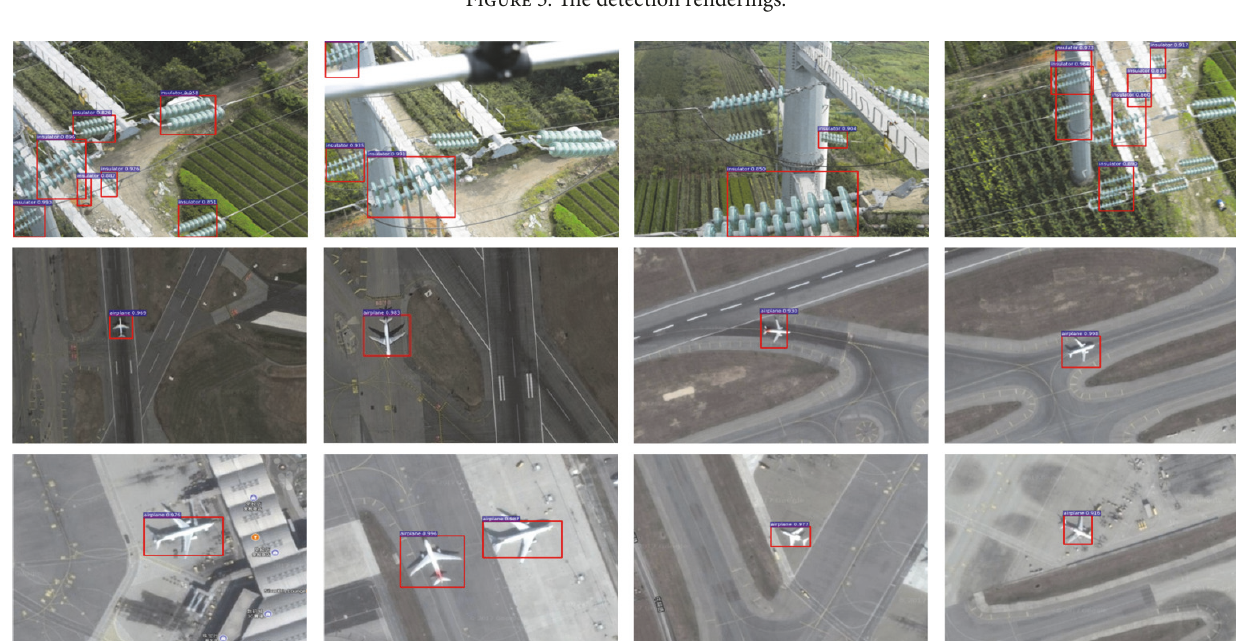
Figure 6: Effect of remote sensing image